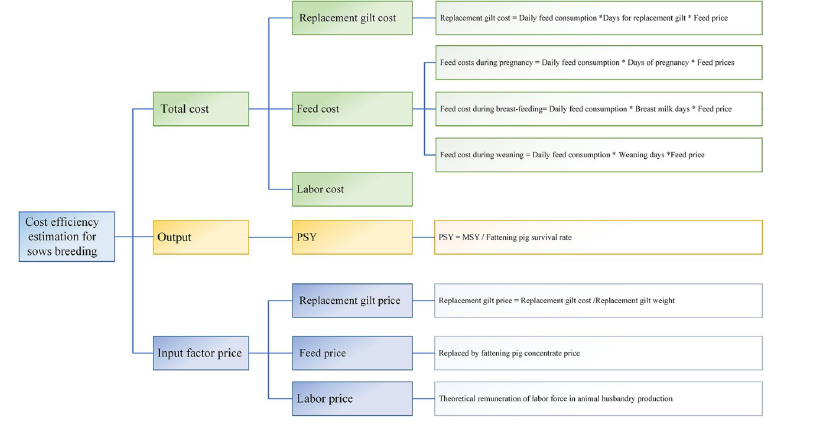
Fig 2. Cost efficiency estimation framework for sows